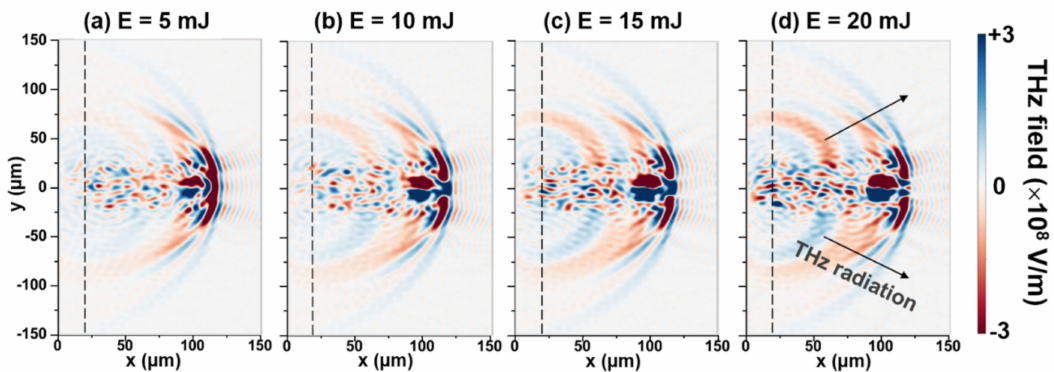
Figure 9. 2D PIC simulation results for THz pulse generation by the two-color method: 2D-plot of the THz electric field strength with a different laser pulse energy of ( a ) 5 mJ, ( b ) 10 mJ, ( c ) 15mJ, and ( d ) 20 mJ. The result shows that a stronger THz wave is generated by a higher laser pulse energy. In the figures, the black dashed line indicates the focal plane of the laser pulse, and the black arrows indicate the THz wave